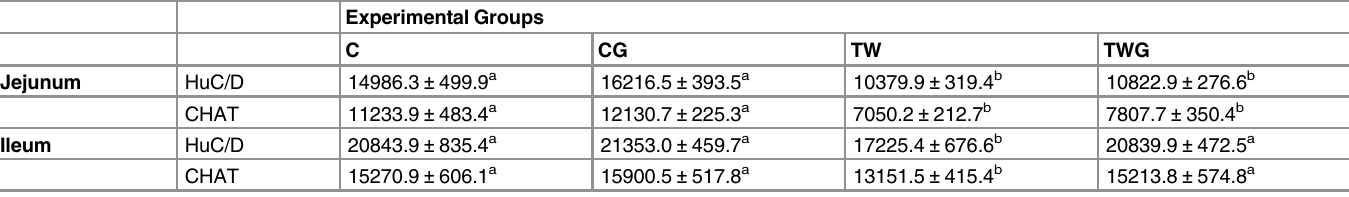
Table 4. Neuronal density of myenteric neurons (neurons/cm 2 ) in the jejunum and ileum. Experimental groups: control (C); control supplemented with 2% L-glutamine (CG); Walker-256 tumor (TW); and Walker-256 tumor supplemented with 2% L-glutamine (TWG). HuC/D-IR population (neurons/cm 2 ), CHAT-immunoreactive subpopulation (neurons/cm 2 ).